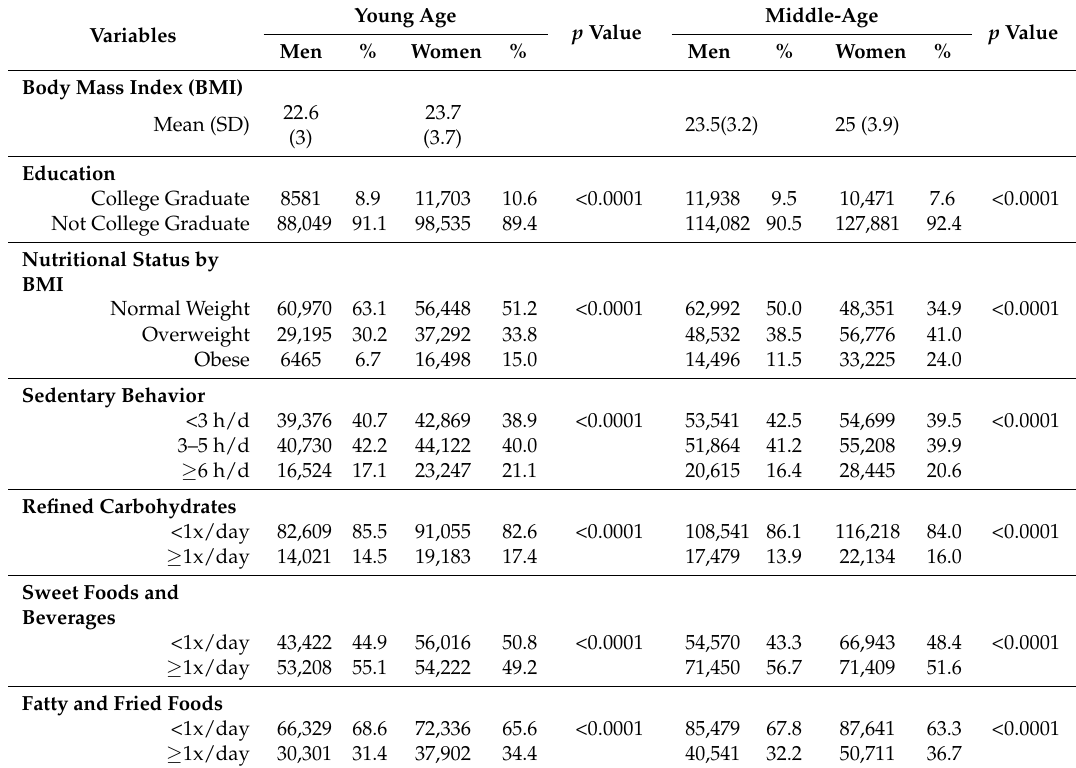
Table 1. Characteristics of the study participants according to age and gender.